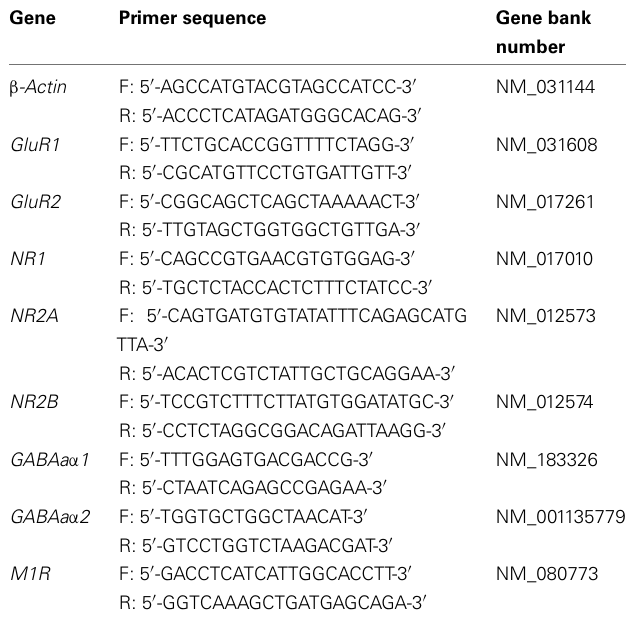
FIGURE 1 | Immunolabeling of transplanted cells. (A) Photograph of a transplanted rat brain.The red arrow indicates the location of the heterotopic cortical transplant of embryonic amygdalar tissue. (B) Photograph of a grafted rat brain after transplant dissection. Note the cavity left by the graft (red arrow). (C) Details of the dissection procedure for graft separation from host tissue. (D) Photomicrograph of Nissl staining in a coronal section through a heterotopic cortical transplant of embryonic amygdalar tissue. Note the clustered distribution of grafted cells. (E) Photomicrograph of GFAP immunolabeling in a coronal section through an amygdalar transplant placed heterotopically in motor cortical location.